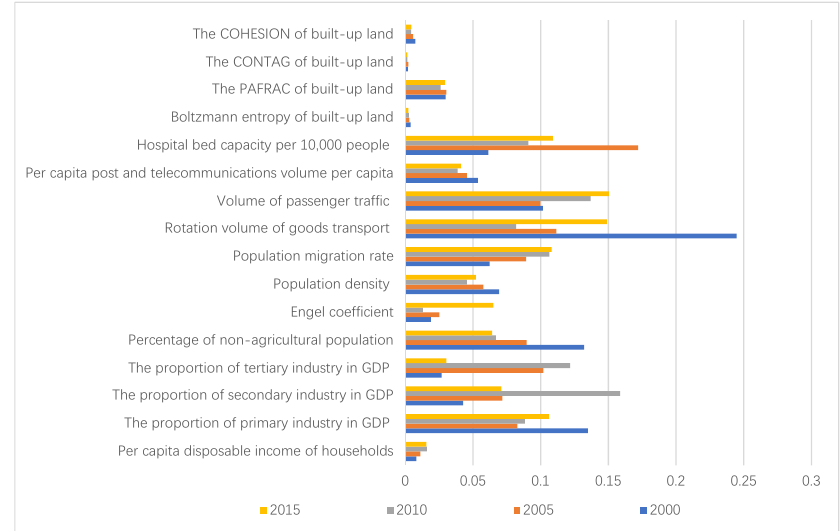
Figure 8. The change of weight of URI indexes from 2000 to 2015.